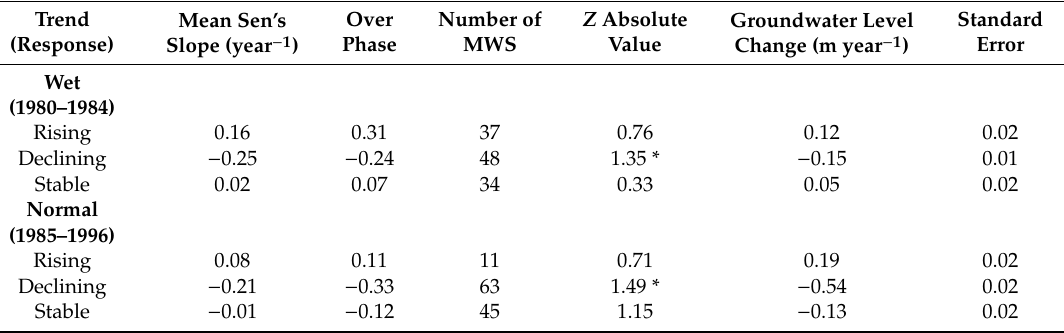
Figure 8. Examples of individual monitoring well time series within the broad types of groundwater responses identified in distinct regions. Table 3. Summary of groundwater responses showing Sen’s slope estimators, number, Z statistics, and mean groundwater level changes, within the response types, across the entire sampling period (1980–2017) and within the climatic phases .